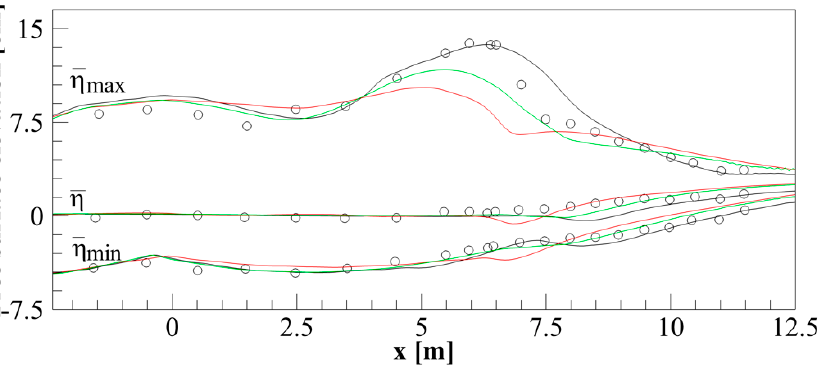
Figure 6. Test 3. Cnoidal wave. Maximum, minimum, and average values of the free ‐ surface elevation. Comparison between experimental data by [23] (circles) and numerical results obtained using the proposed WTENO model (black line), the 2TVD model proposed by Cannata et al. [3] (red line), and the 5WENO model (green line).